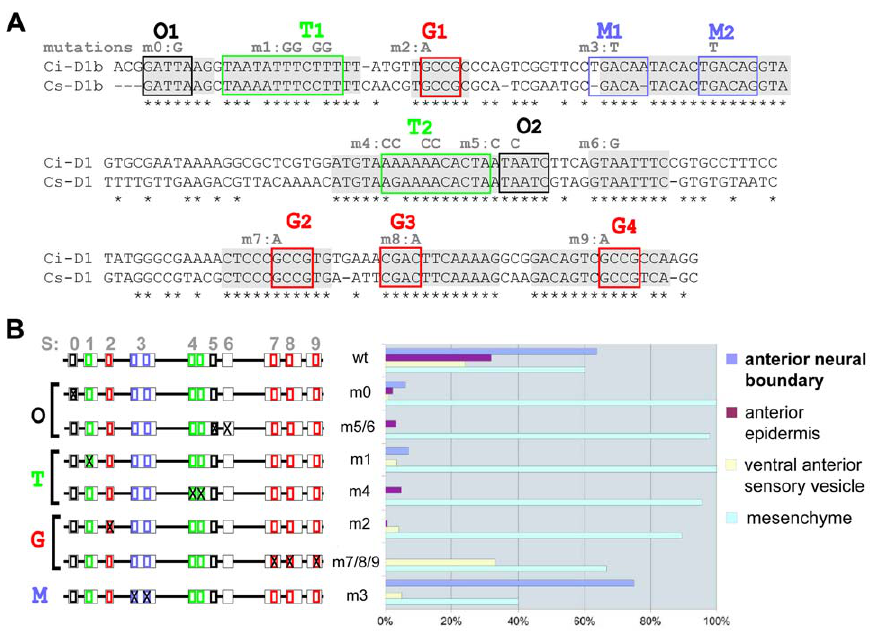
Figure 1. Mutational analysis of D1(bcde) reveals at least three binding sites necessary for its activity. (A) Alignment of D1(bcde) (195pb) between Ci/Cs. Conserved blocks in D1(bcde) with putative transcription factor binding sites (TFBS). Four classes of putative TFBS within ten blocks of conserved sequence: O1 and O2 display the characteristic GATTA/TAATC core sequence that is known to bind K50 Paired -related homeodomain proteins, including otx/otd, pitx and goosecoid. Putative Fox protein binding sites were identified in the blocks called T1 and T2 (T/A- rich). Blocks M1 and M2 show similarity to known binding sites of the TALE-class Meis/TGIF homeodomain proteins. Finally, putative Smad1/5/8 binding sites were observed in blocks labelled G1, G2, G3 (G/C-rich). Conserved blocks of nucleotides are highlighted in grey. Putative binding sites are represented by colored boxes. Mutations designed to disrupt the binding specificity of each sites are indicated in grey above the sequence (m0 to m9). (B) Schematic representation of D1(bcde) and series of mutations introduced into the pD1bcde:CES2 construct. On the right is shown for each construct the rate of mid-tailbud embryos expressing the lacZ reporter in the anterior neural boundary (anb), the anterior epidermis (ae), the ventro- anterior sensory vesicle (vasv) and the mesenchyme (mes) (wt n=444; m0 n=198; m1 n=56; m2 n=348; m3 n=40; m4 n=58; m5/6 n=182; m7/8/9 n=29). Most mutations led to a general reduction of the expression level in all of aforementioned domains, while mesenchyme expression remained high. Only construct m3 (block M1 and M2) retained the activity in the anterior neural